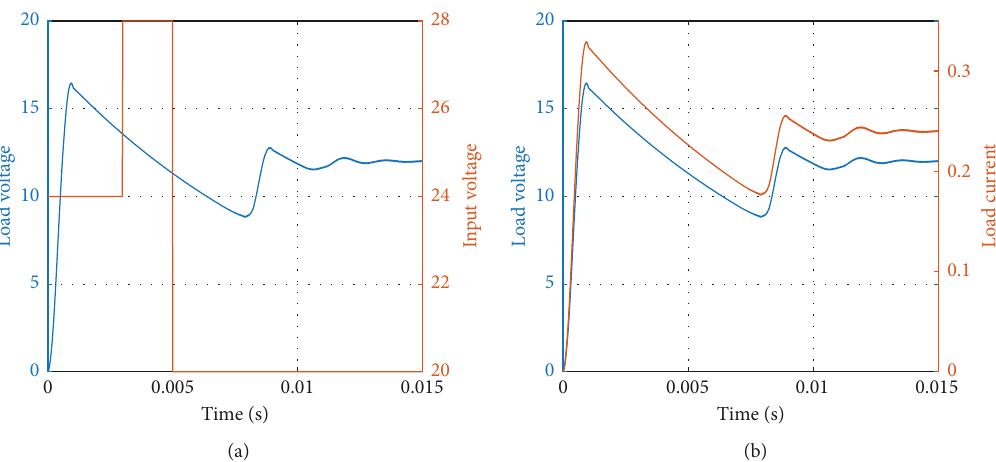
Figure 11: Plot for (a) output load voltage and the variable input voltage and (b) output current and voltage for varying input voltage case using the IMC controller.